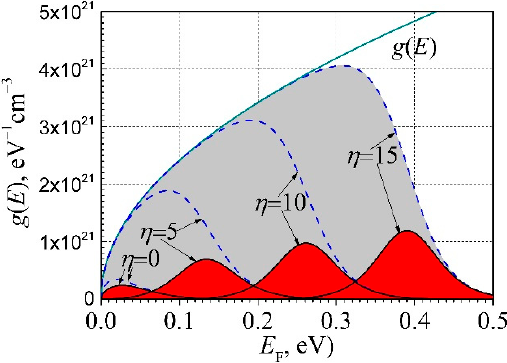
Figure 1. Illustration of DOS g ( E ) (green solid line) dependent functions: g ( E ) f ( E ) (blue dash lines), and g ( E ) f ( E )[1 − f ( E )] (black solid lines) for various η values: 0; 5; 10; 15. The area under the curve g ( E ) f ( E ) (shaded by light grey color) represents the total density of electrons in the conduction band n (Equation (3)), and the area under the curve g ( E ) f ( E )[1 − f ( E )] (shaded by red color) represents the effective density of randomly moving electrons n eff (Equation (1)). Here DOS is described by Equation (5) by changing E F to E .